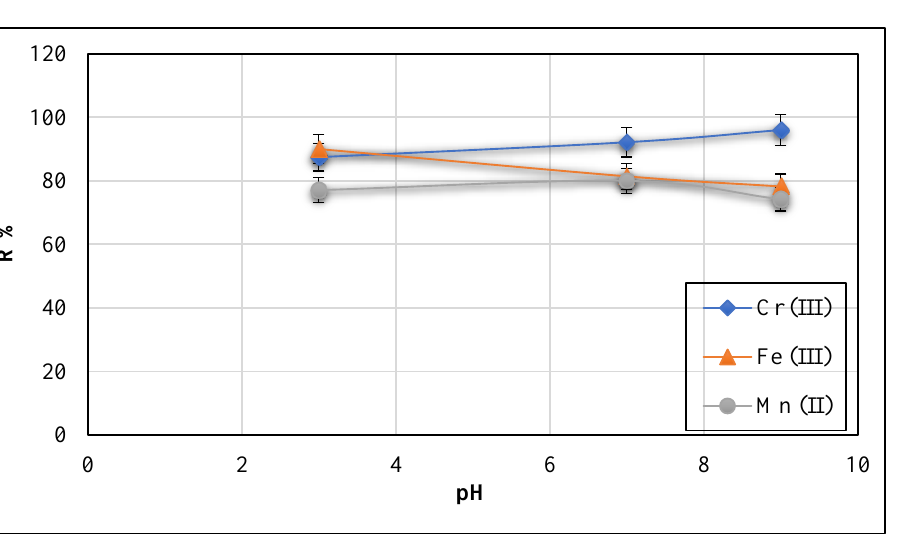
Figure 13. Effect of temperature on Cr (III), Fe (III), and Mn (II) removal at Conc. 20 mg/L and pH 9.